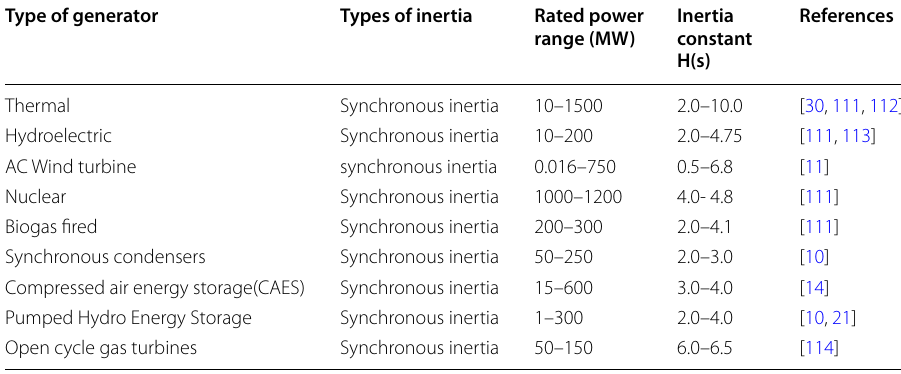
Table 4 Summary of inertia values of different power generators Type of generator Types of